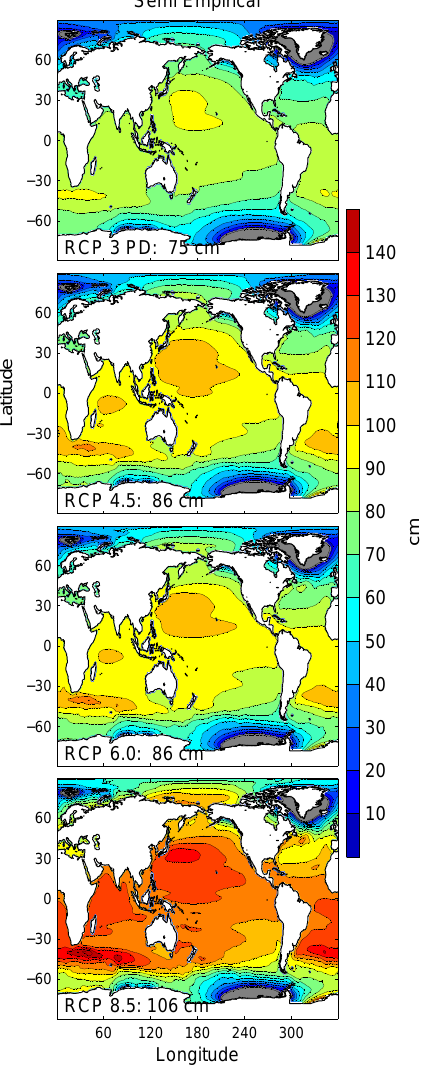
Fig. 8. Projected median regional sea level change for all RCP sce- narios (from RCP 3PD to RCP 8.5) in the semi-empirical ice sheet case. Contour lines are every 10cm. Grey shading indicates areas of sea level drop. Note the colour scales is different from Fig. 7.